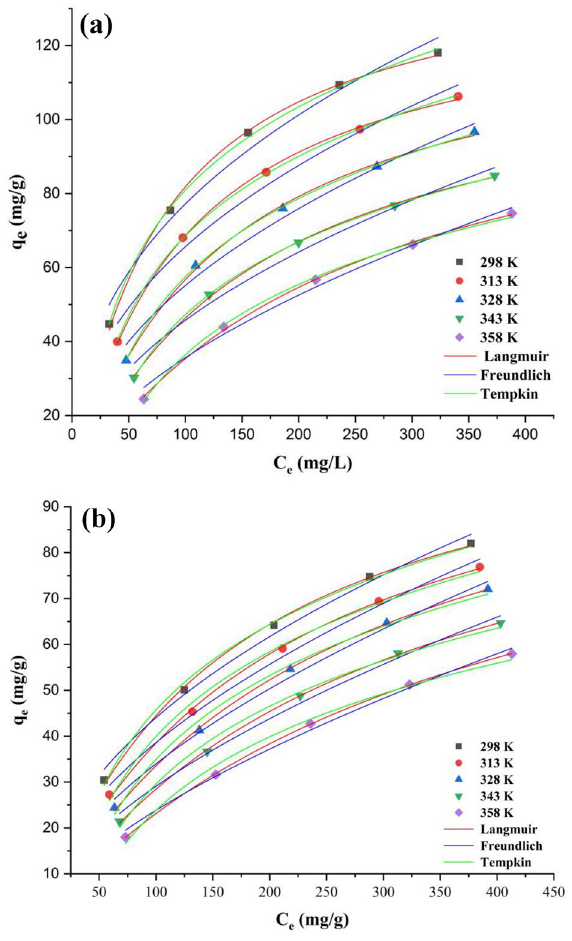
Figure 7. Adsorption isotherm curves for phenol removal using ( a ) MSAC and ( b ) pristine activated carbon (pH = 7, concentration = 1.5